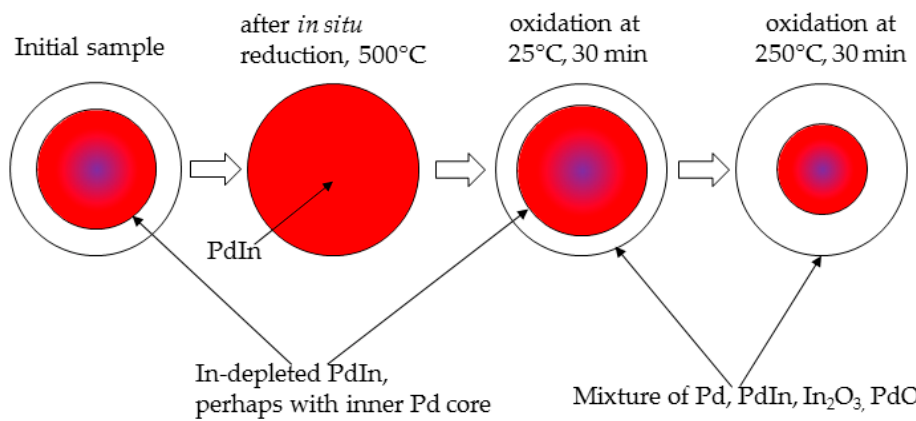
Figure 4. Tentative models of supported PdIn nanoparticles after the reductive and oxidative treat- ments.